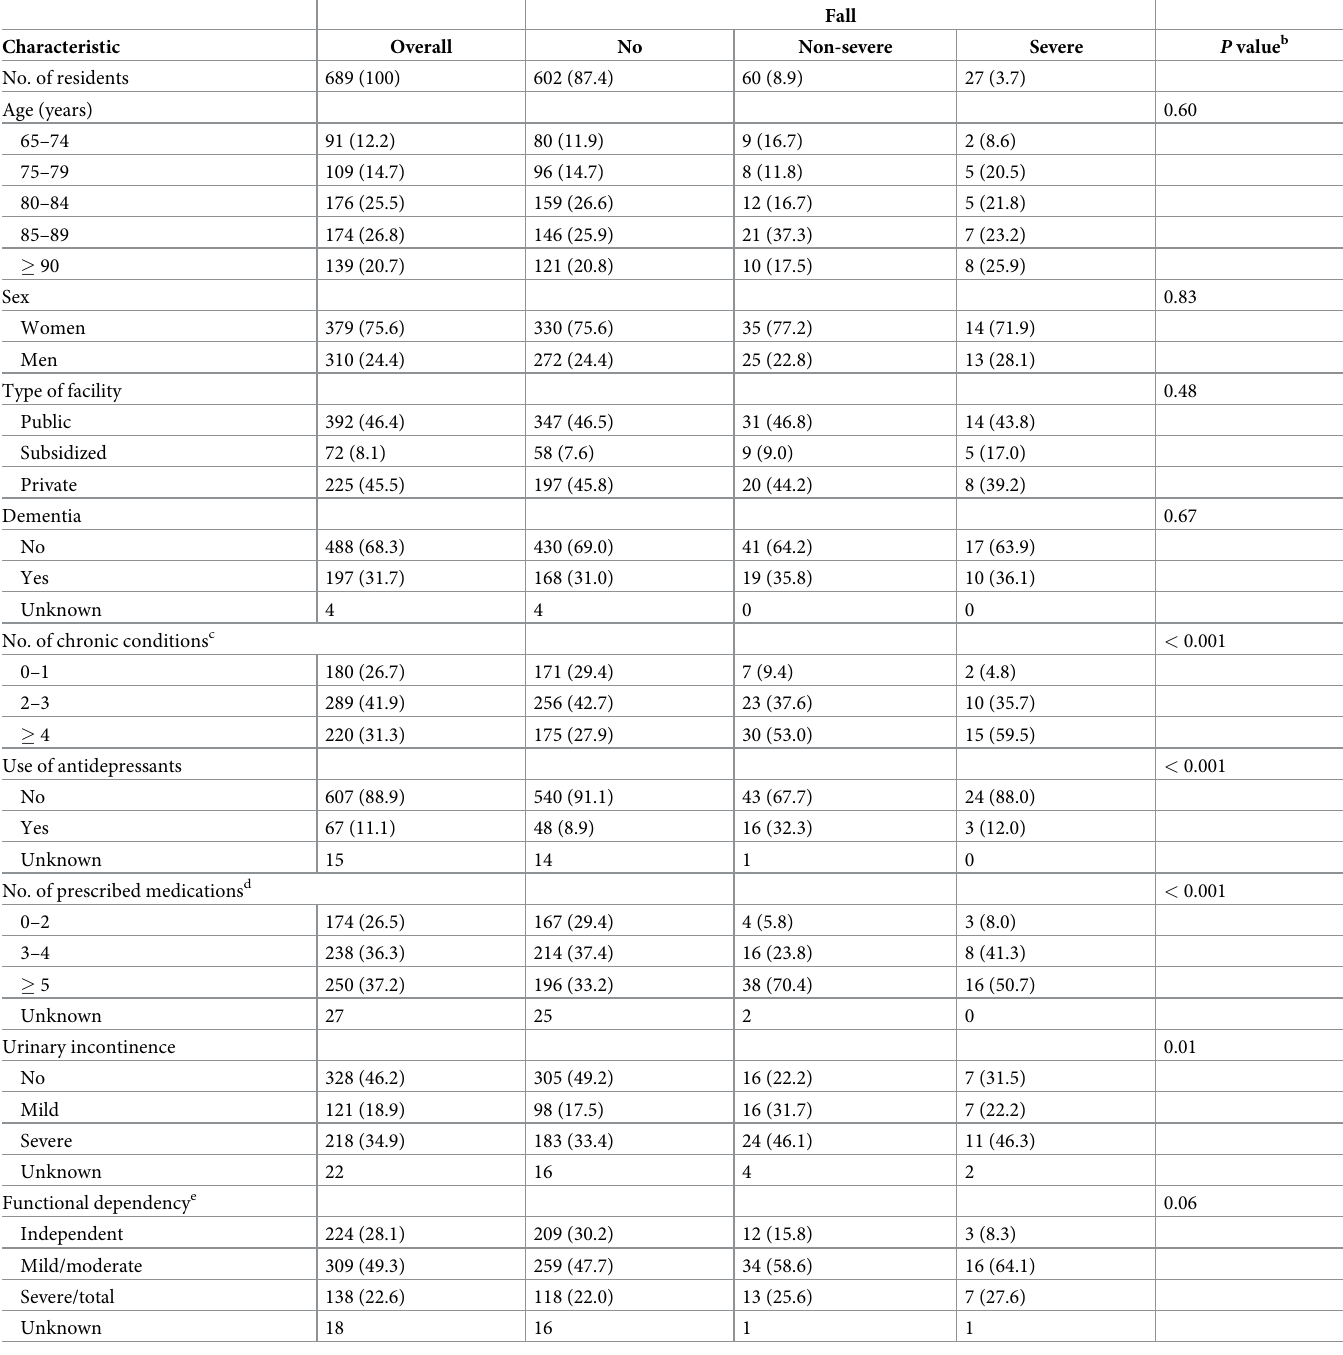
Table 1. Baseline characteristics of nursing home residents by severity of fall (1998–1999) a